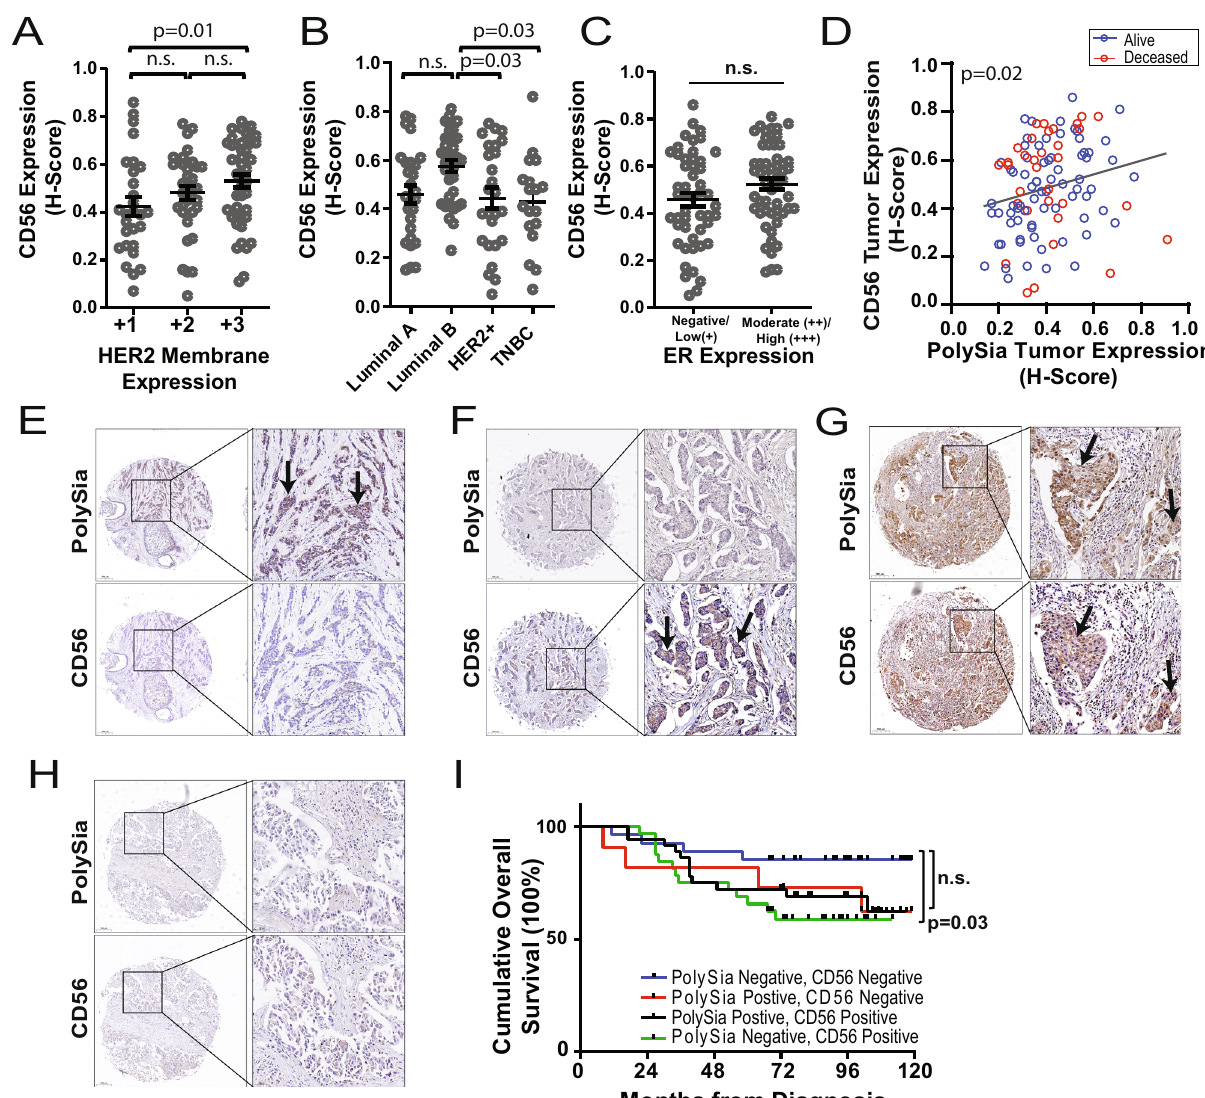
Fig. 6 PolySia and CD56 tumor cell expression in HER2 expressing tumors and correlation with patient outcomes. A – C Analysis of CD56 expression ( H -Score) in HER2 expressing tumors ( n = 106) categorized by A HER2 membrane expression levels, B molecular subtype, or C ER expression. Bars indicate medians and ±SEM, p < 0.05 denotes signi fi cance. Tukey ’ s Test ( A , B ) and unpaired t -test ( C ). D Correlation between CD56 expression levels plotted relative to polySia expression levels for each matched tissue core. Each data point was pseudo-colored based on patient outcome (Red = Deceased, Blue = Alive). Gray Line = Regression line for all matched tissue cores. Pearson correlation test and simple linear regression test. E – H Immunohistochemical staining of polySia (top row) and CD56 (bottom row) in each panel in breast cancer tissue. Representative images are shown alongside higher magni fi cation insets from the same core. Arrows point to clusters of cells positive for polySia and/or CD56. Scale bar = 200 µm (cores), or 50 µm (insets). I Kaplan – Meier curves for overall survival of individuals based on polySia and CD56 expression levels in tumor cells. Patient tumors were categorized as polySia-CD56 positive ( n = 36), CD56 positive/polySia negative ( n = 32), polySia positive/CD56 negative ( n = 11) and polySia low/negative, CD56 low/negative ( n = 27). Tumors with a H -Score > 0.4 for each marker were classi fi ed as polySia and/or CD56 positive; cut-point value was set at the median ± SEM of all values. Overall survival curve comparison: Log-rank (Mantel – Cox) and in the context of lymphocytes, polySia has been documented to occur on NK and CD3 + T cells with CD56 being a carrier protein and, in line with our work, these studies also found ST8Sia4 to be the sialyltransferase responsible for polySia synthesis 16,17,29 . In addition, for NK cells, CD56 and polySia expression were reported to increase following activation with IL-2 suggesting polySia levels are regulated by NK cell activation state. While CD56 and polySia expression clearly fl uctuate with activation state, whether or not they have a direct role in immune function is not well described. A small number of studies support an active role for